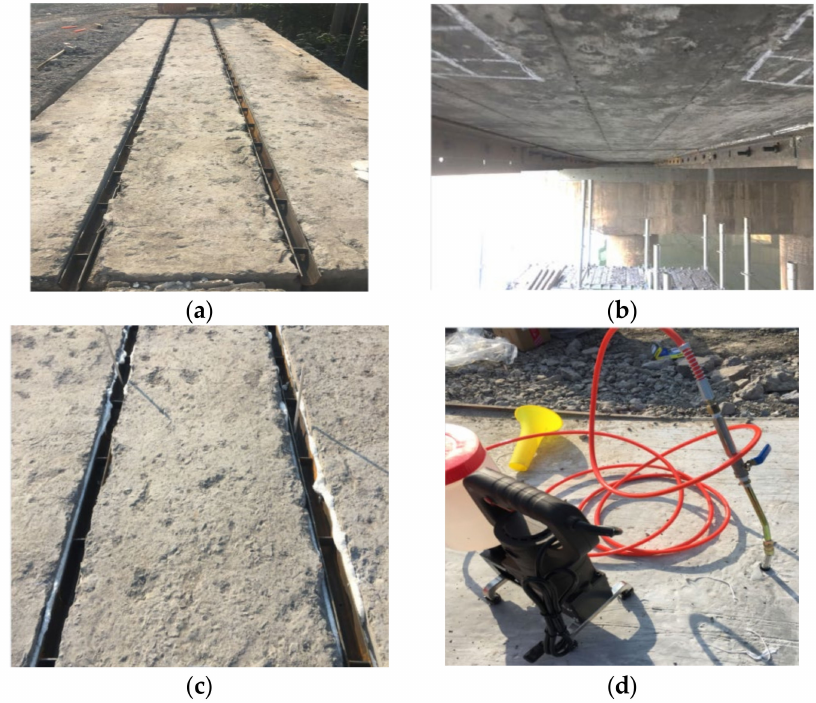
Figure 4. Process of the ESP strengthening method. ( a ) Cleanup and installation. ( b ) Sealing treatment. ( c ) Insertion of PVC pipe. ( d ) Cast-in-place and grout.